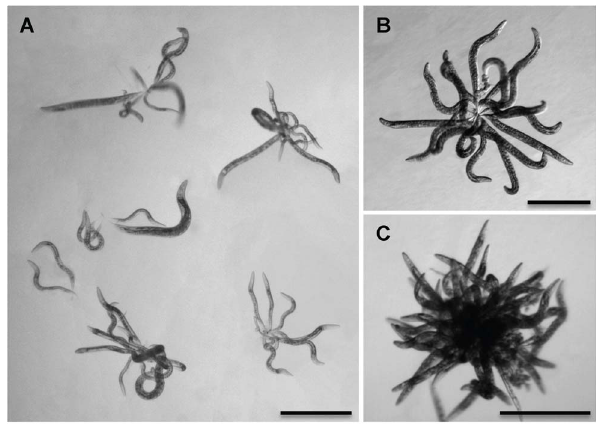
Figure 3. DBL-1 signaling affects surface adhesion. (A) Six worm- stars show larval and adult dbl-1(nk3) hermaphrodites knot by their tails. Scale bar = 0.5 mm. (B, C) dbl-1(nk3) adult animals become tangled by their tails, forming moderate (B) or dense (C) worm-star aggregates in liquid. Scale bars = 0.5 mm.